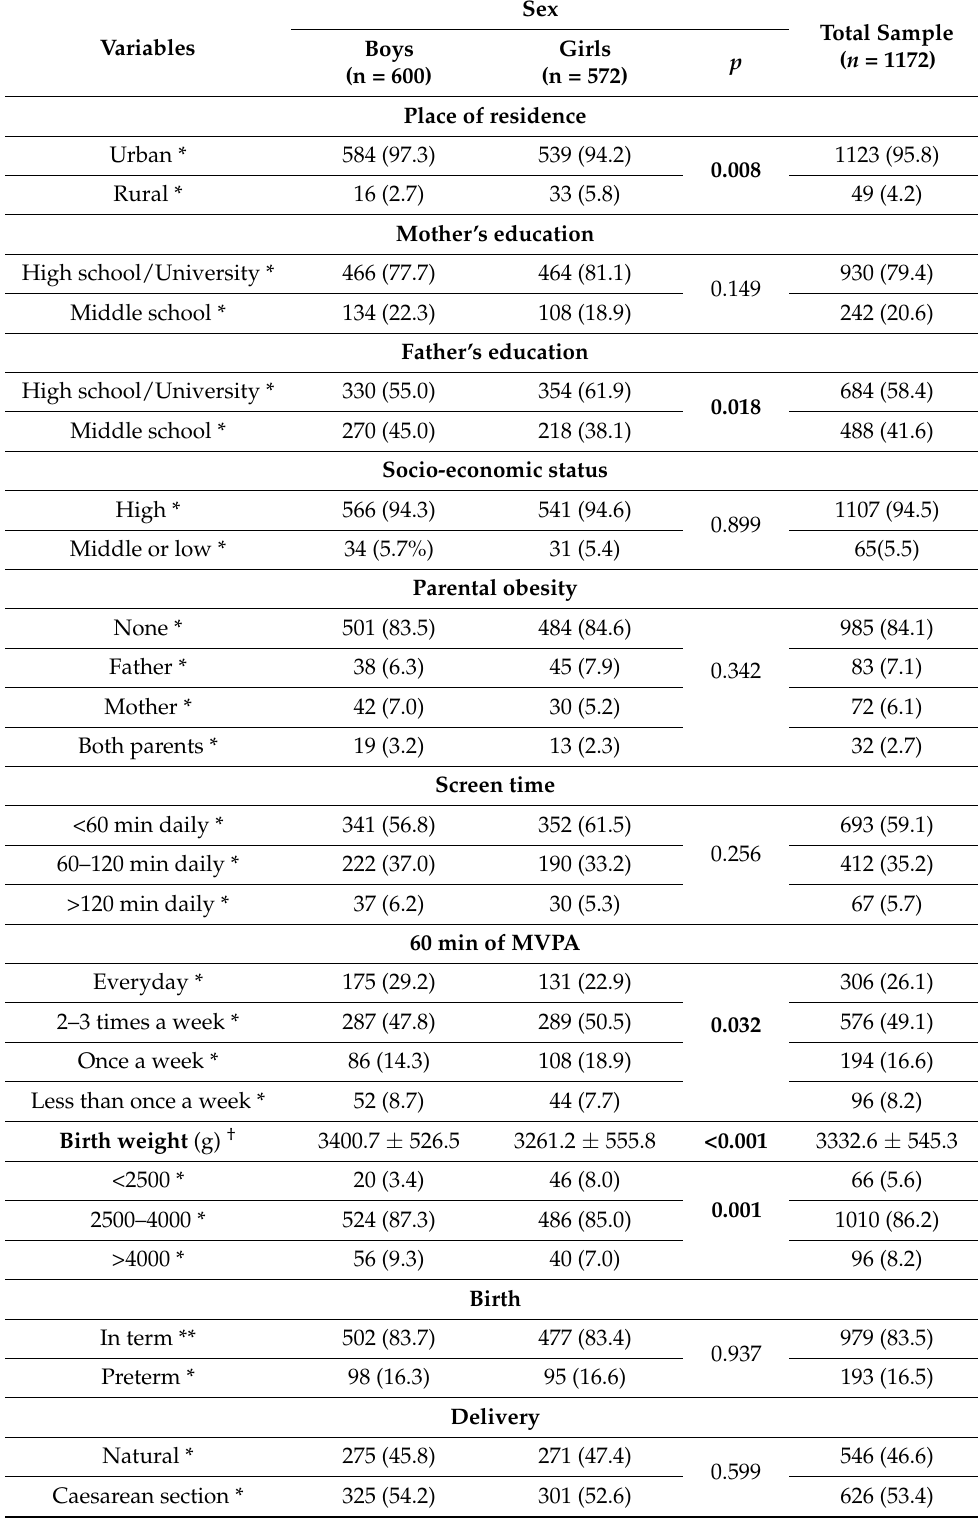
Table 2. Distribution of potential childhood obesity risk factors according to